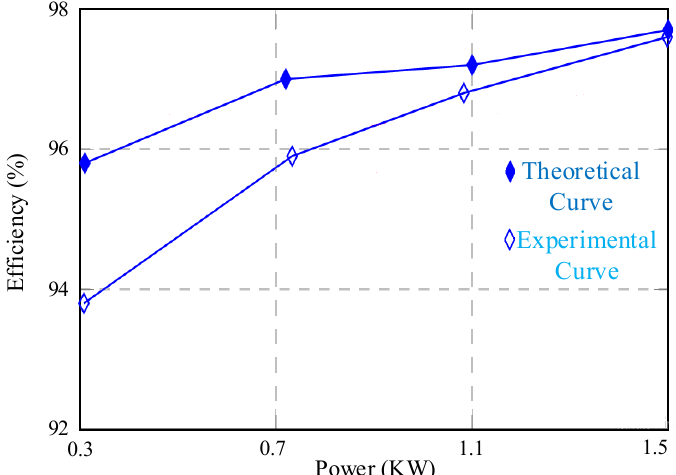
Figure 14. Comparison of Power Efficiencies ( V in = 60 V, V s = 120 V).